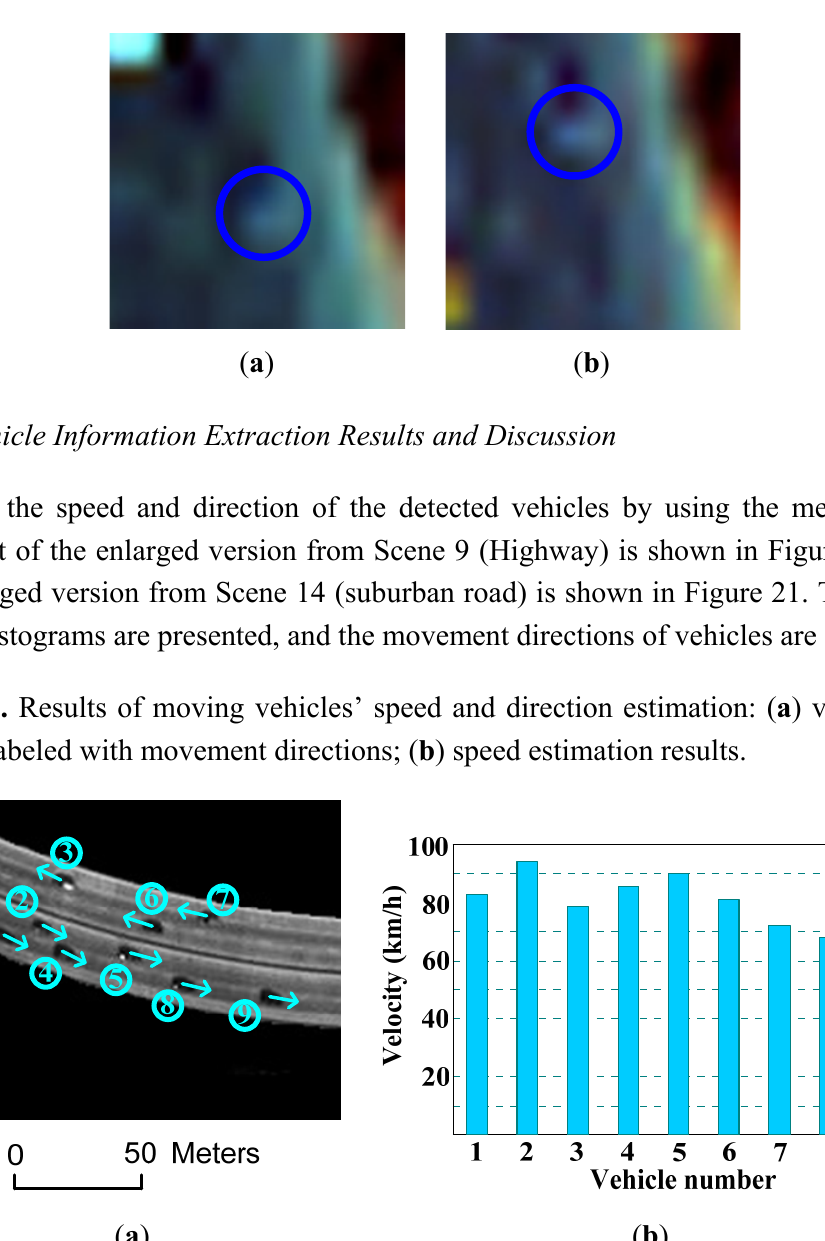
Figure 19. A vehicle has a similar spectral value to the road: ( a ) MS1 image; ( b ) MS2 image.